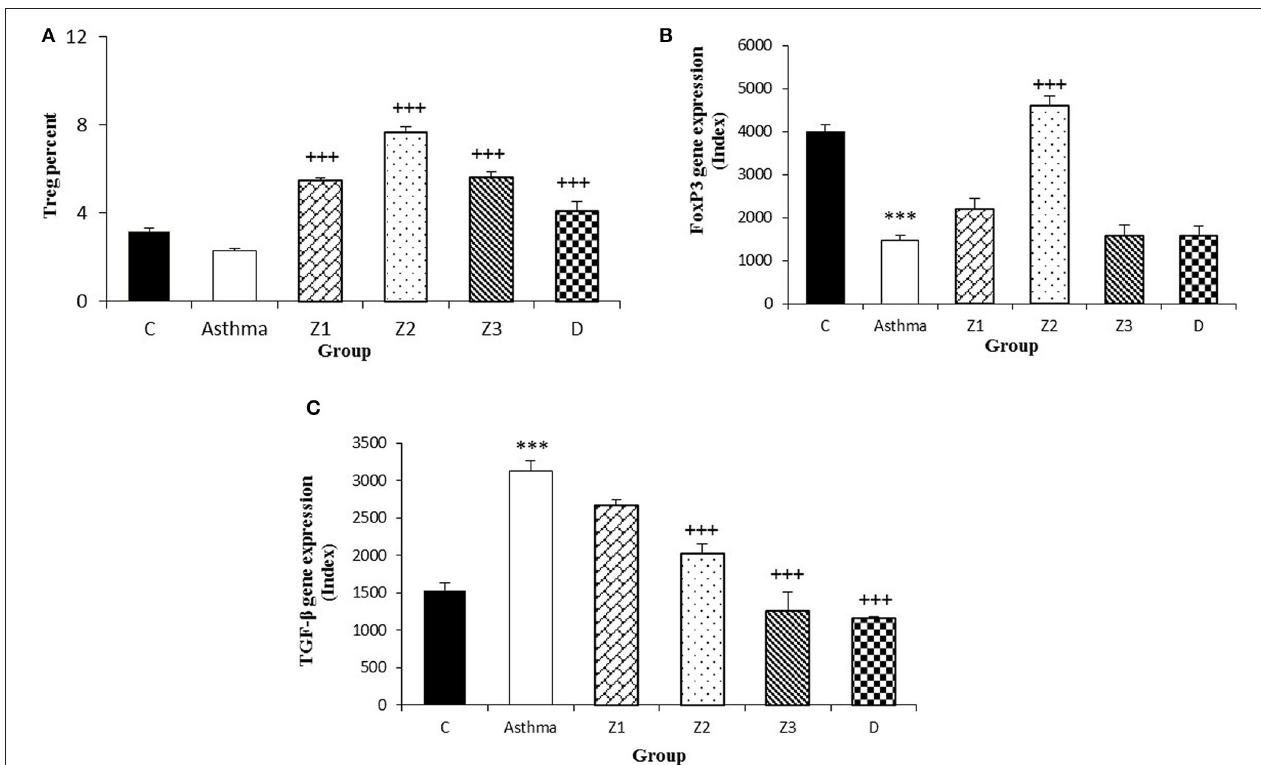
FIGURE 5 | Percent of Treg cells (A) , values of FOXP3 (B) , and TGF- β (C) gene expression in splenocyte from control group (C, n = 5), Asthma group (A, n = 5), and A treated groups with the extract of Z. multiflora at concentrations 200, 400, and 800 µ g/mL (groups Z1, Z2, and Z3, respectively, n = 6) and dexamethasone (D, n = 5). Data were presented as mean ± SEM. *** p < 0.001, vs. control group. +++ p < 0.001, vs. asthma group. The statistical comparisons were made using ANOVA with Tukey–Kramer multiple post-hoc test.